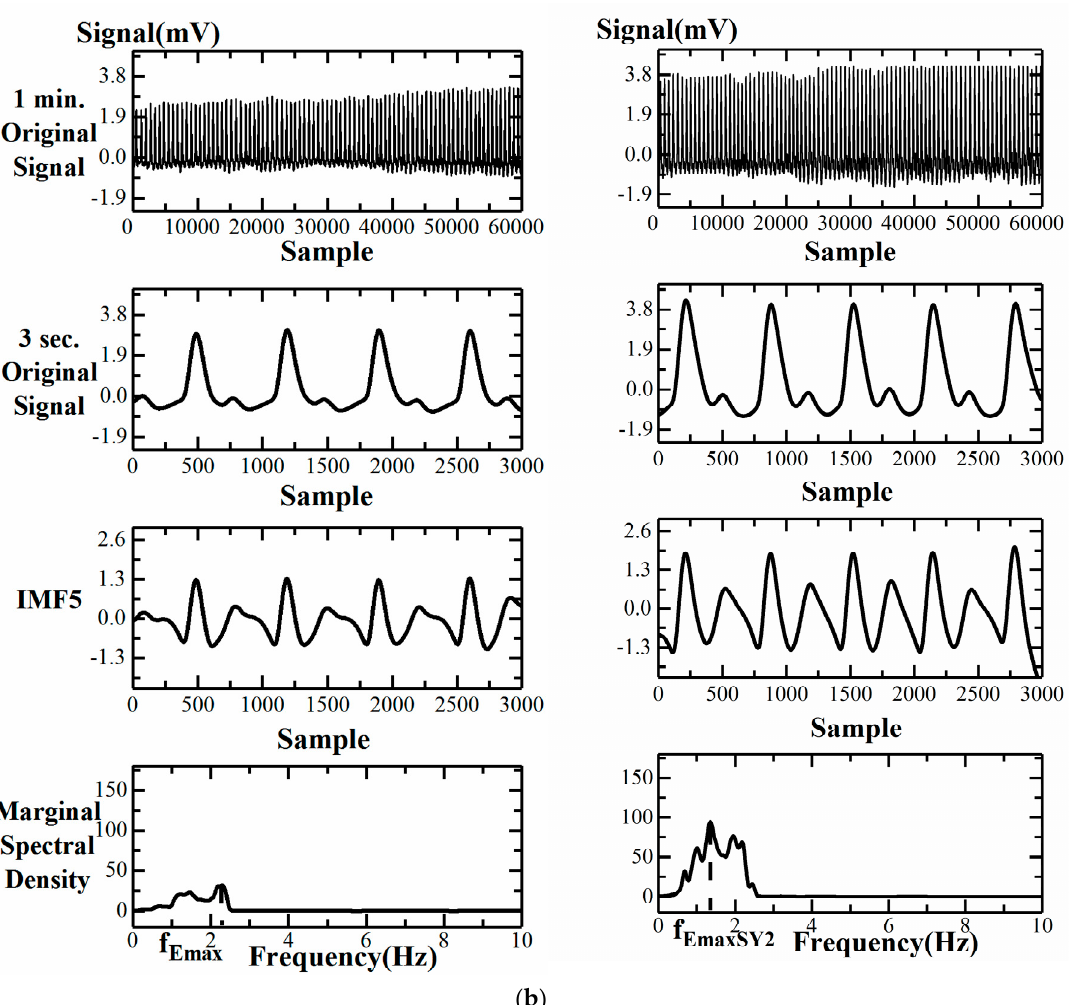
Figure 3. Representative illustrations of the original DVP waveforms for 60 s and 3 s, intrinsic mode function 5 (IMF5) after ensemble empirical decomposition (EEMD), and the marginal spectral density of IMF5 from the dominant index fingertip. ( a ) DVP waveforms from a healthy 20-year-old man in Group 1. Left panel: waveforms before SY2 was attached, with the following calculated parameters: SI = 5.25 m/s, CT = 0.19 s, CTR = 0.15. Right panel: waveforms after SY2 was attached, with the following calculated parameters: SI = 5.40 m/s, CT = 0.20 s, CTR = 0.15, FPI = − 9.82%, Δ f Emax = − 0.05 (Hz). ( b ) DVP waveforms from a healthy 48-year-old woman in Group 2. Left panel: waveforms before SY2 was attached, with the following calculated parameters: SI = 5.41 m/s, CT = 0.20 s, CTR = 0.14. Right panel: waveforms after SY2 was attached, with the following calculated parameters: SI = 5.24 m/s, CT = 0.20 s, CTR = 0.15, FPI = 70.89%, Δ f Emax = 0.88 (Hz). These figures elevated the instantaneous frequency corresponding to the maximal energy (i.e., f Emax vs. f EmaxSY2 ) in the healthy young man, compared to the elder healthy subject.